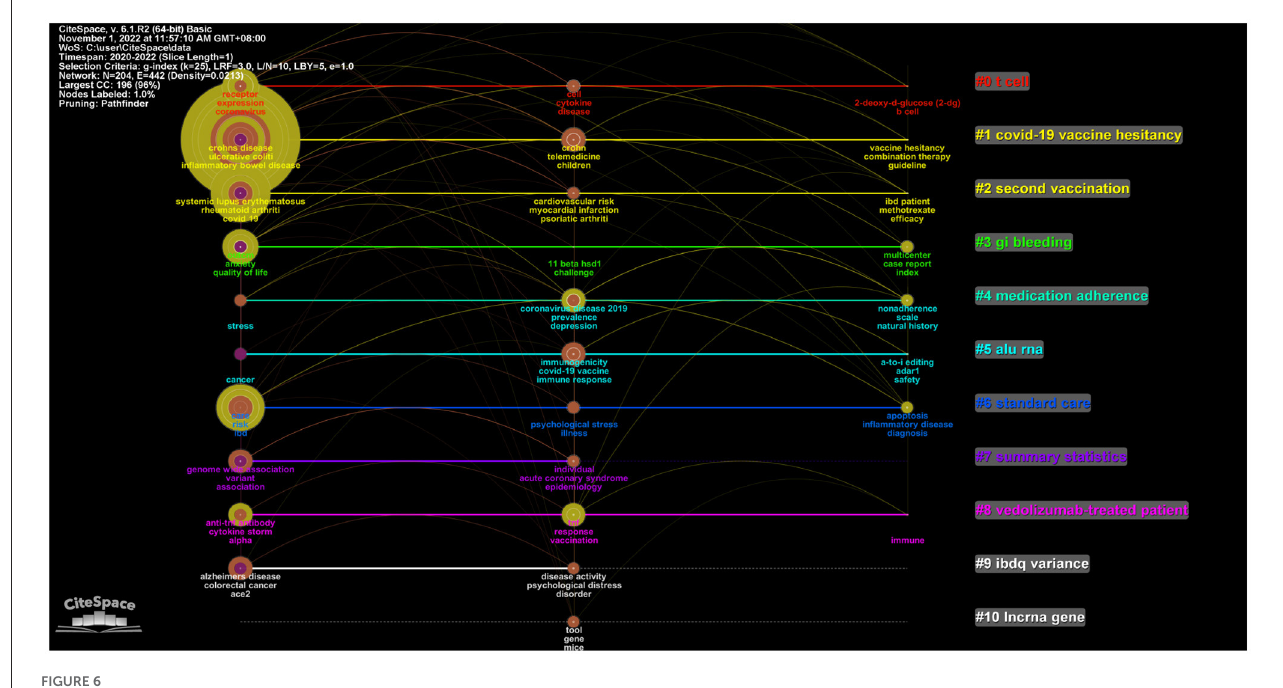
FIGURE6 The cluster analysis of keywords in the field of IBD and COVID-19.